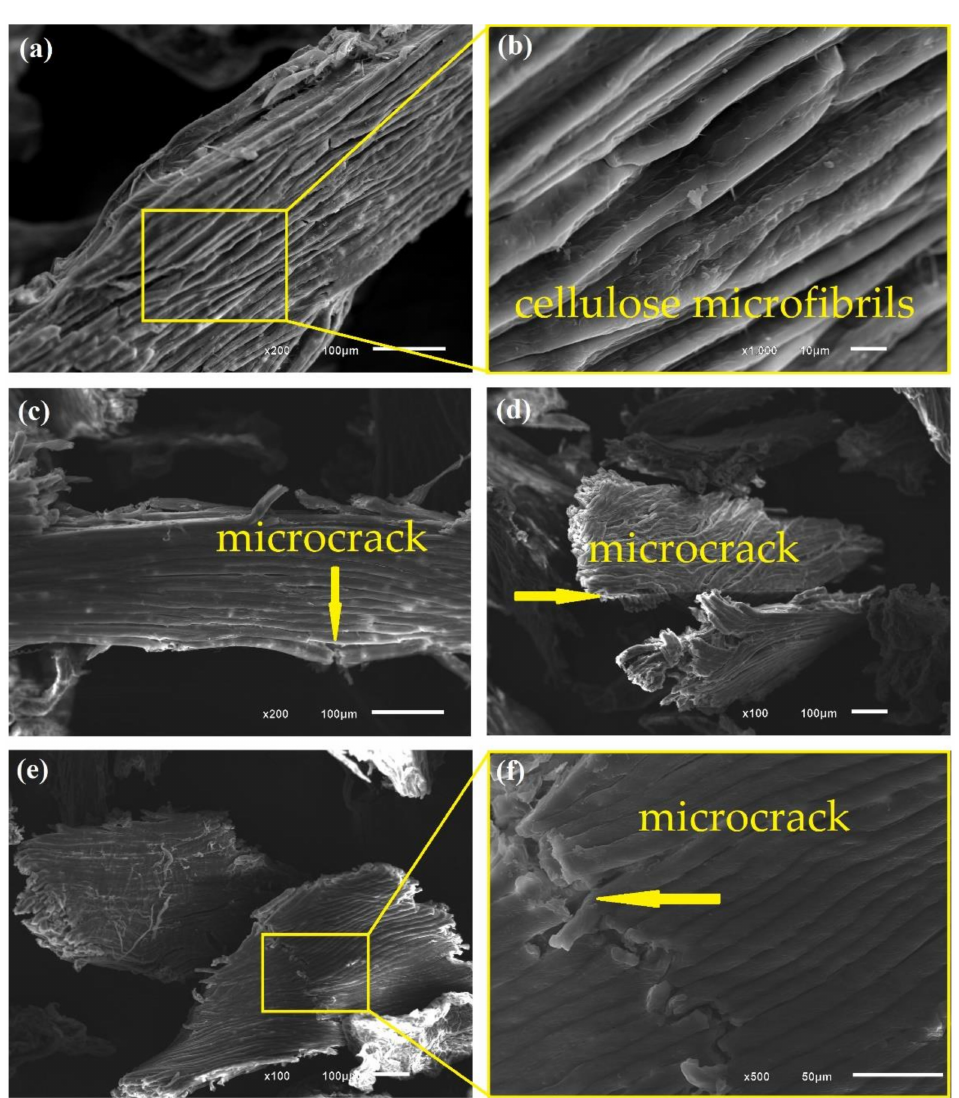
Figure 6. Photomicrographs of CHFW after NaOH 5 ( a , b ); NaOH 10 ( c , d ); and NaOH 20 ( e , f )